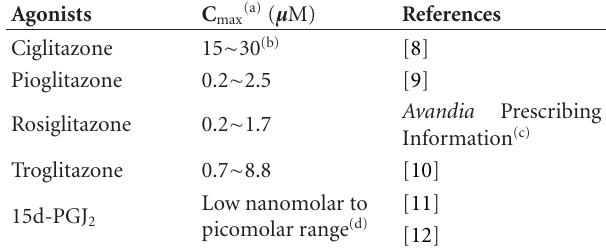
Table 2: Peak plasma concentrations of PPAR γ agonists.